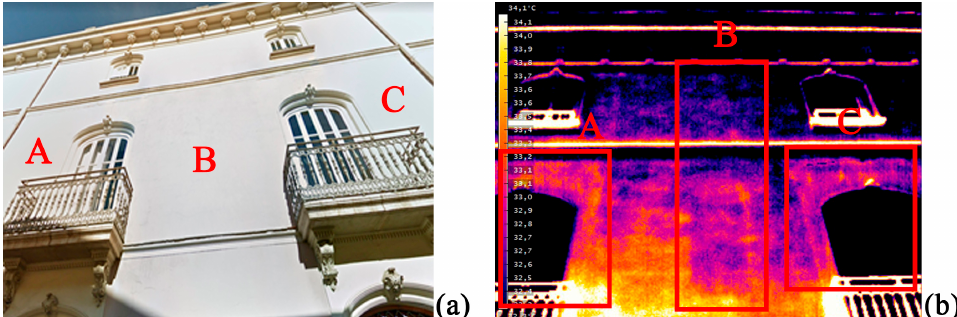
Figure 14. ( a ) Colour image of a section of the eastern façade of the Palacio; ( b ) thermal image of the same area. It is possible to observe some anomalies not visible in the colour image but clearly detectable in the thermal image (highlighted in red as A, B and C).